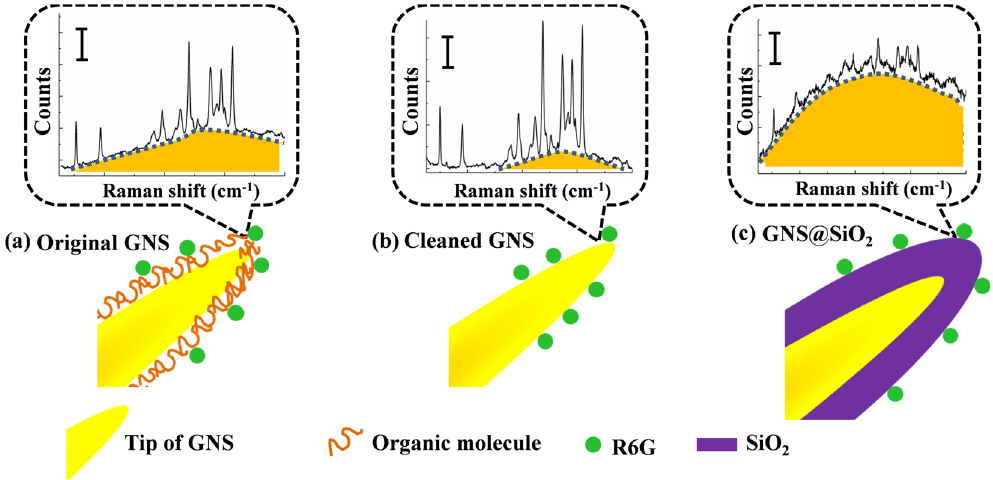
Figure 8. Schematic illustrations of surface-treatment GNS demonstrating the competing relationship of fluorescence and surface enhanced Raman scattering. ( a ) Original GNS. ( b ) Cleaned GNS. ( c ) GNS4@SiO 2 .